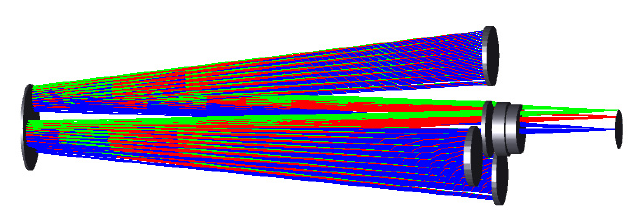
Table 3. The parameters of the three-element corrector group.